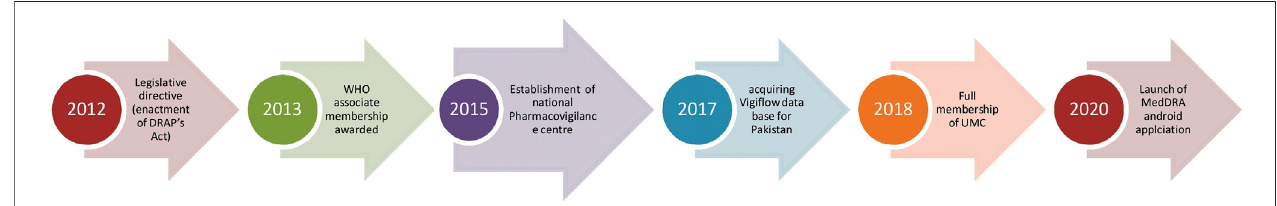
FIGURE 1 | Events of establishment of the national pharmacovigilance center of Pakistan with